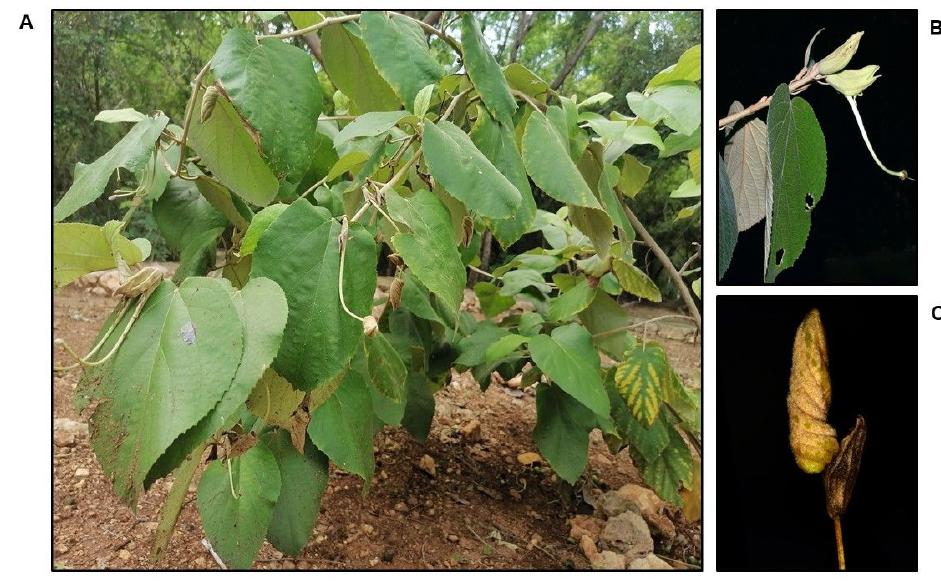
Figure 2. Helicteres baruensis : ( A ) shrub; ( B ) flower; ( C ) fruit.